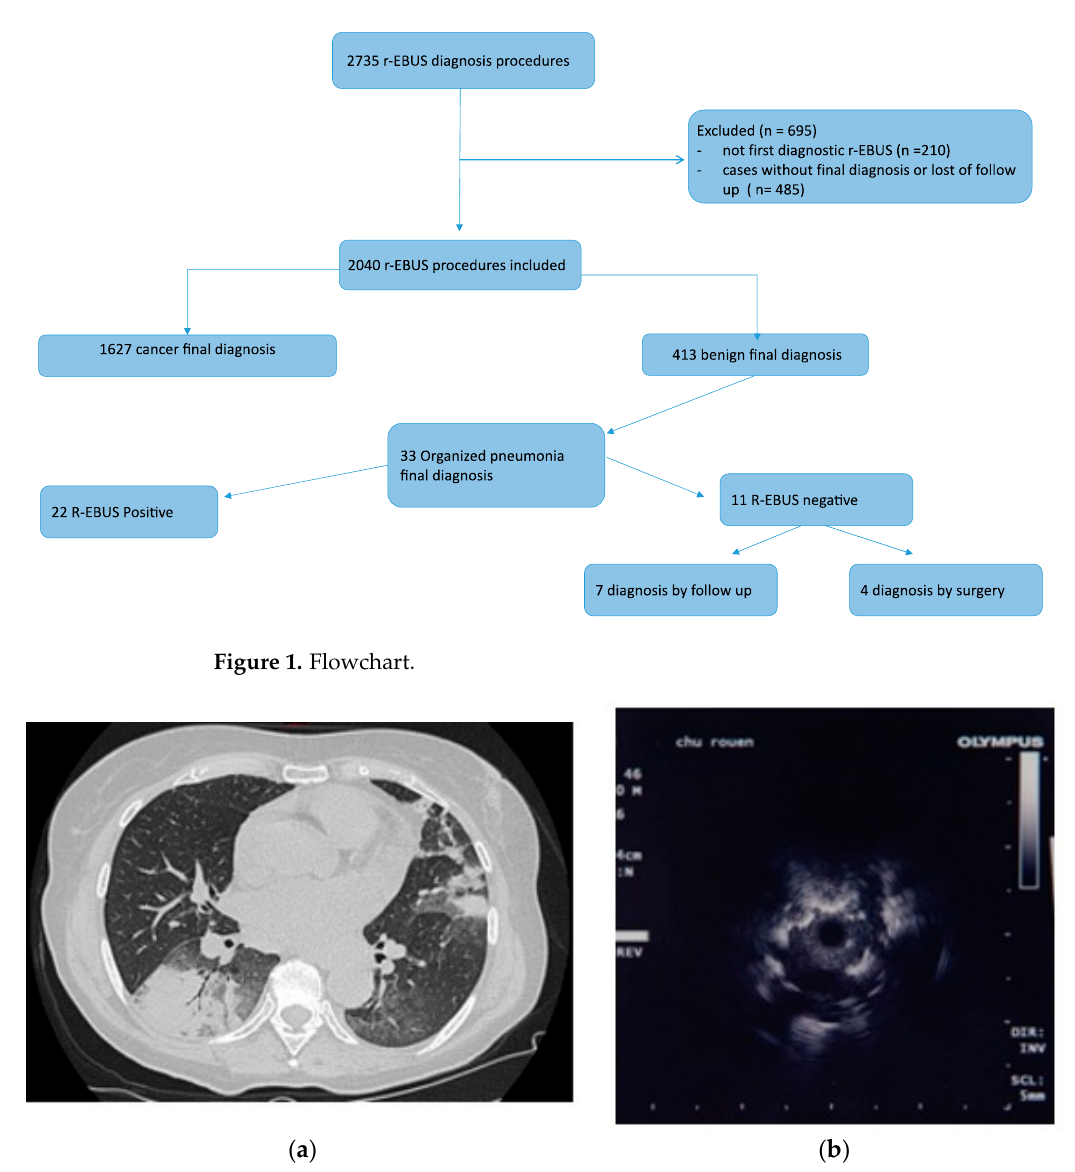
Figure 2. CT-scan image of organizing pneumonia with bilateral alveolar opacities ( a ). Ultraso- nographic image of organizing pneumonia ( b ).